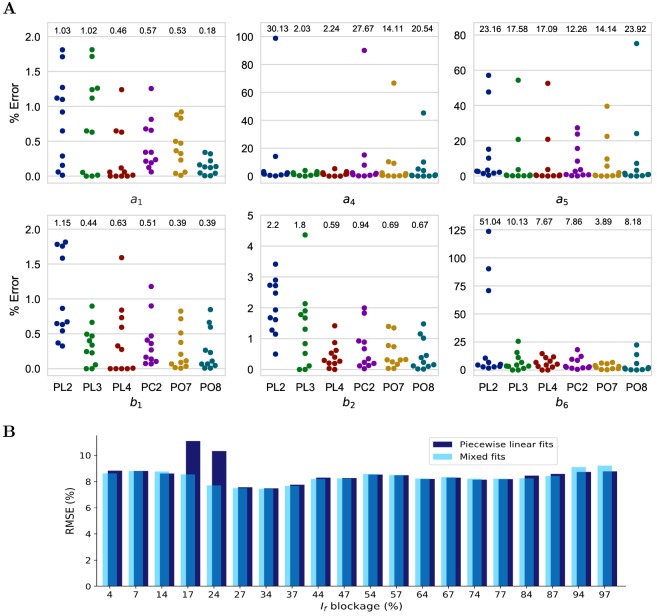
Selection of the small error and resource utilization friendly fitting curve to the coefficients for the Resonant model optimization.A: Percentage errors for different levels of If block and root mean squared errors (displayed at the top of every fit) for various types of fits to the resonant model coefficients. Piecewise linear with one breakpoint (PL2), piecewise linear with two breakpoints (PL3), piecewise linear with three breakpoints (PL4), piecewise cubic with one breakpoint (PC2), degree 7 polynomial (PO7), and degree 8 polynomial (PO8). B: Percentage root mean squared error (RMSE) for 20 If blockage percentage values when: 1) all the coefficients were fitted with minimum RMSE piecewise linear fits only (dark blue), 2) when all the coefficients were fitted with minimum RMSE fits, i.e., mixed fit types (light blue).